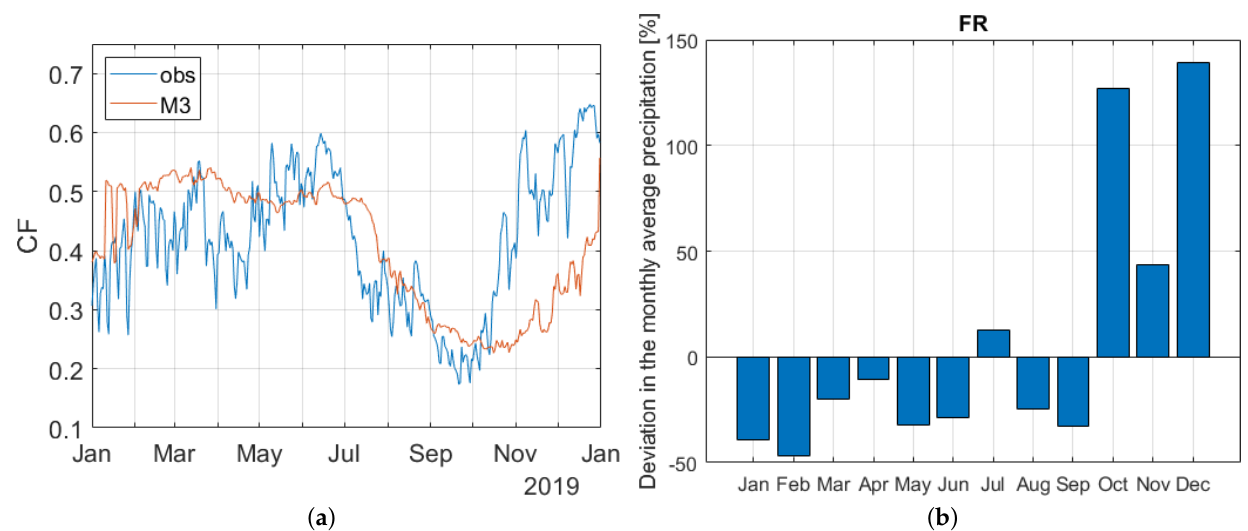
Figure 8. ( a ) Time series of the observed and modeled capacity factor over the test year 2019, with training set over 2015–2018. ( b ) Deviation of the monthly average precipitation in 2019 from the monthly average precipitation in the four previous years.